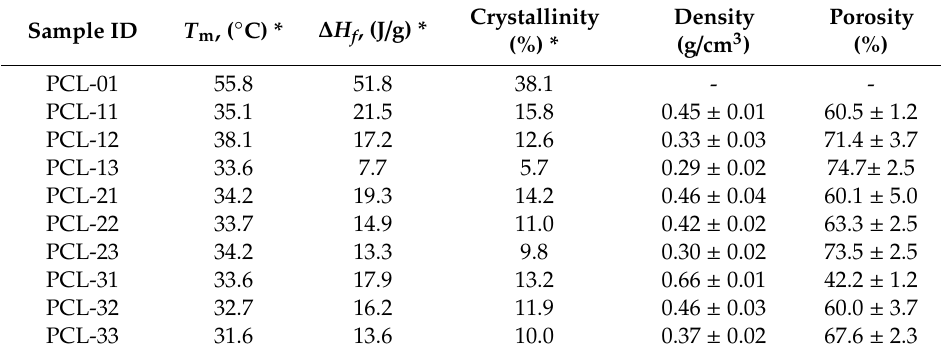
Table 2. Thermal properties, density and porosity values of crosslinked PCL sca ff